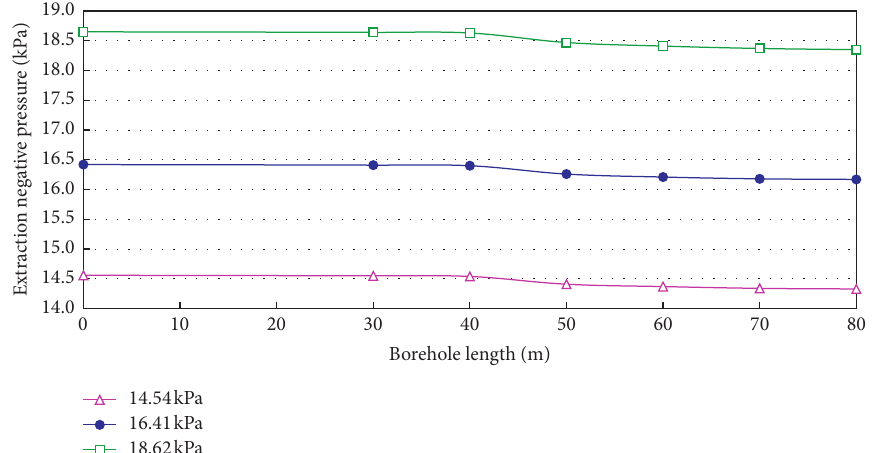
Figure 16: The gas extraction negative pressure distribution of borehole along the borehole length for 1 day after